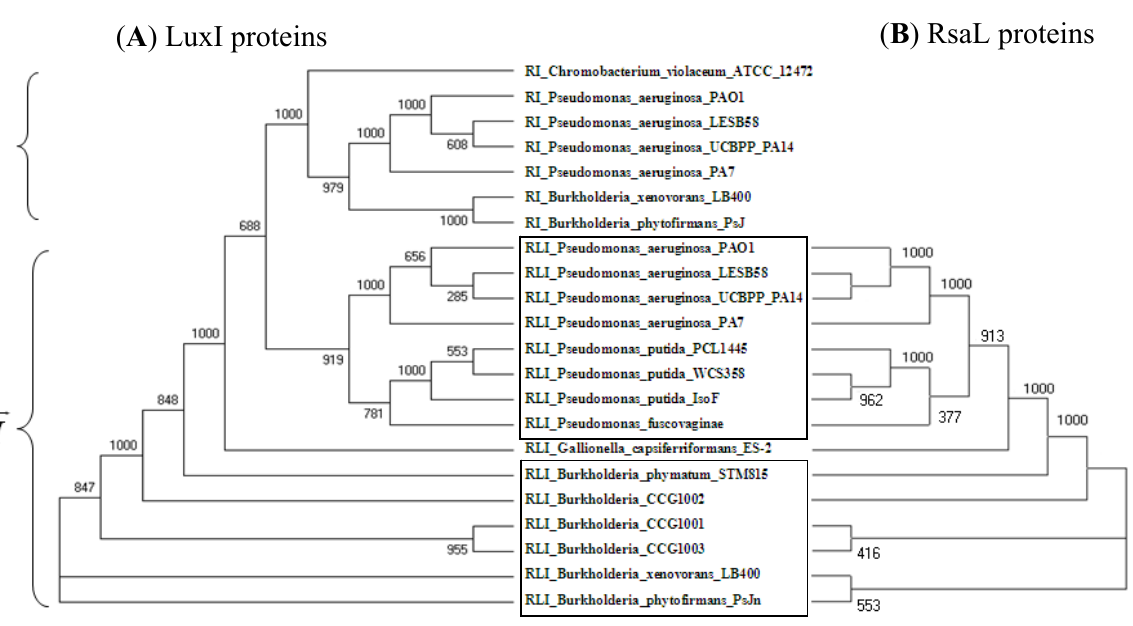
Figure 2. Clustering of LuxI and their negative regulators RsaL shows identical tendencies. ( A ) shows tree of LuxI proteins present RI and RLI pattern, and ( B ) shows RsaL proteins in RLI pattern. The sequences were taken from genomes harboring rsaL genes located between luxR and luxI genes. The clustering was carried out by the Phylip program package [52]. The numerical value at each node indicates the bootstrap value supporting every split in the lineage (out of 1,000 bootstrap